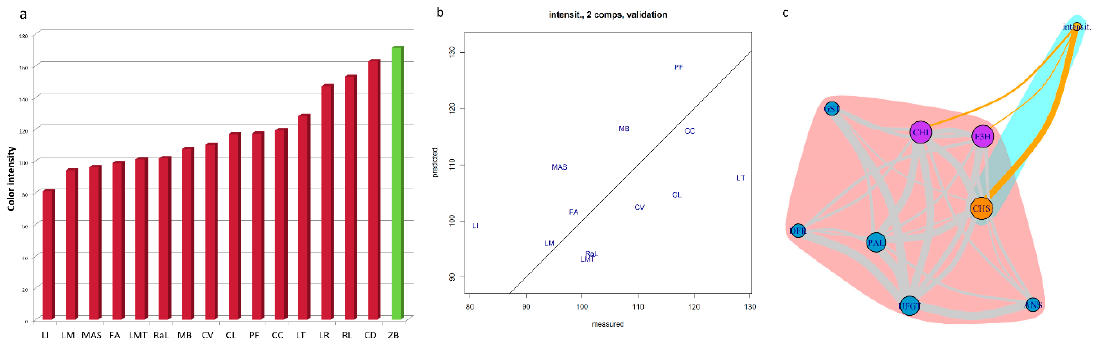
Figure 6. Statistical analyses of the quantitative trait of anthocyanins accumulation in petals. The accessions are indicated with codes: ‘Incomparabile’—LI, ‘Meyer’—LM, M. australasica var.